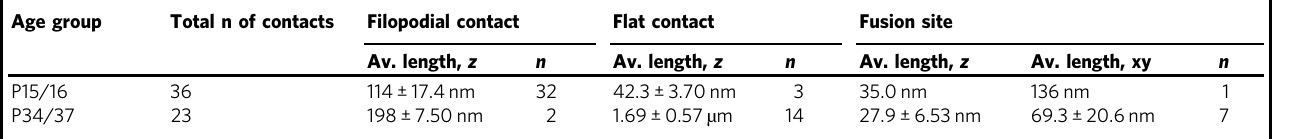
Table 1 Summary of the contact site quanti fi cation of the FIB-SEM datasets.